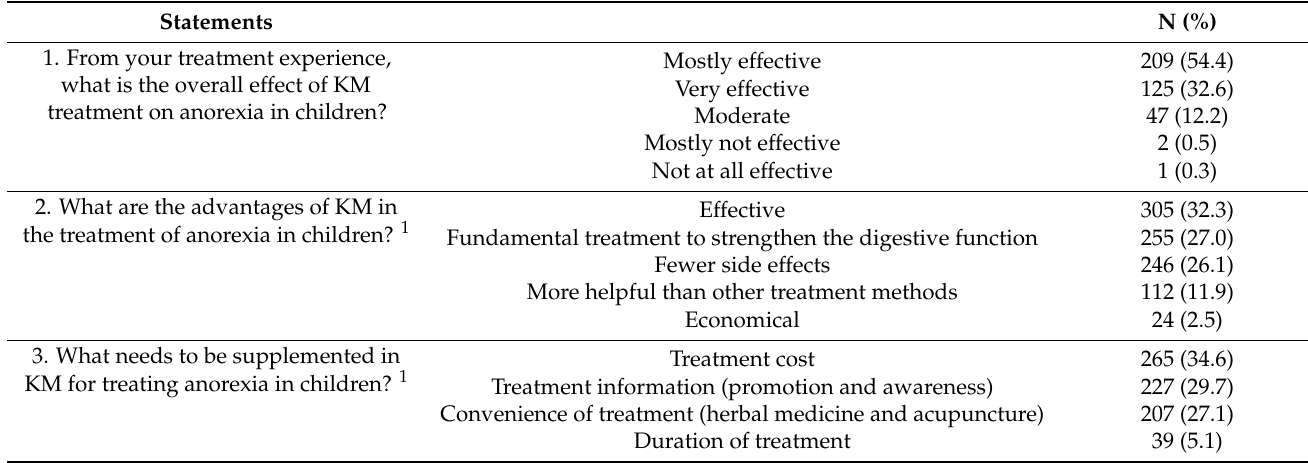
Table 5. Perception of Korean medicine in the treatment of children with anorexia (N = 384).